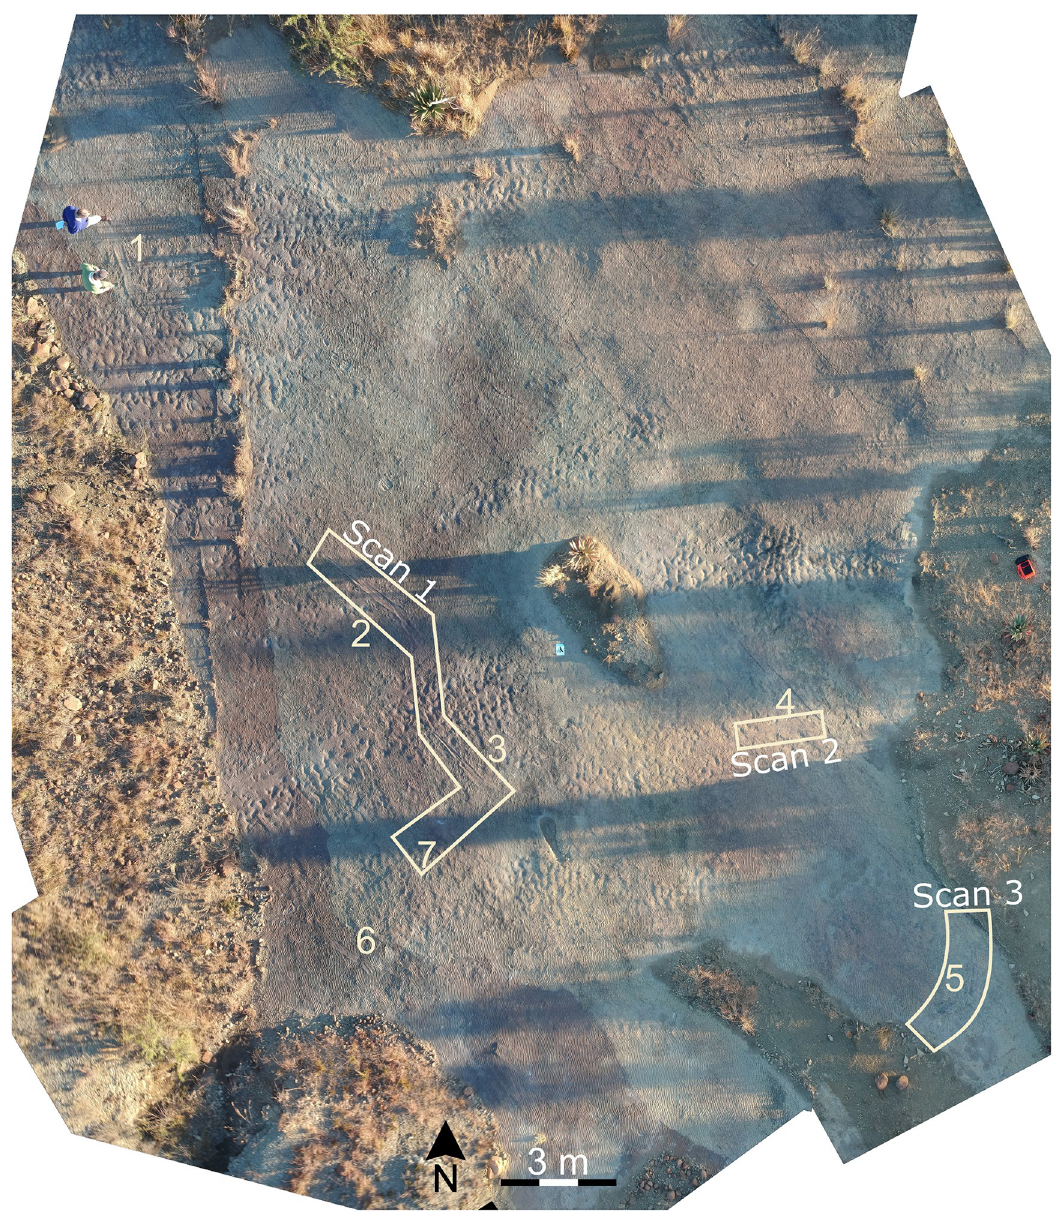
Fig 2. Orthophoto of the palaeosurface with the positions of the seven large impressions and paths followed for the high- resolution scans indicated. Numbers used for the impressions are the same throughout the